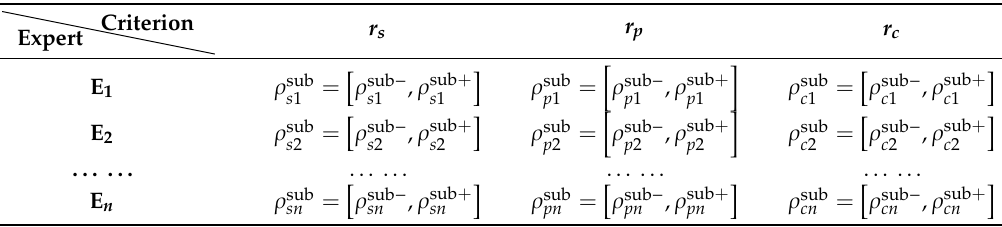
Table 1. Subjective weights given by